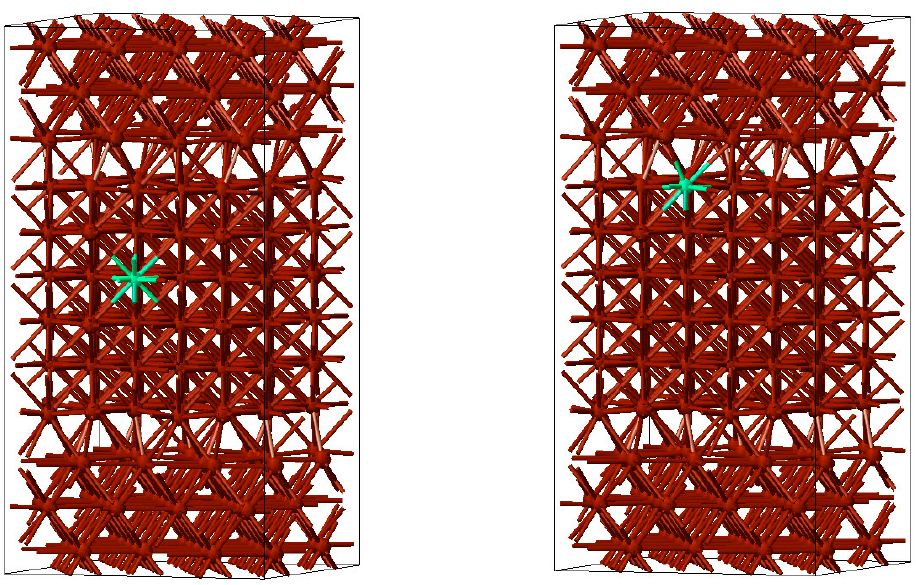
Figure 8. Model of a Cu microstructure with a Cl atom at the centre of the grain ( left ) and at the grain boundary ( right ).